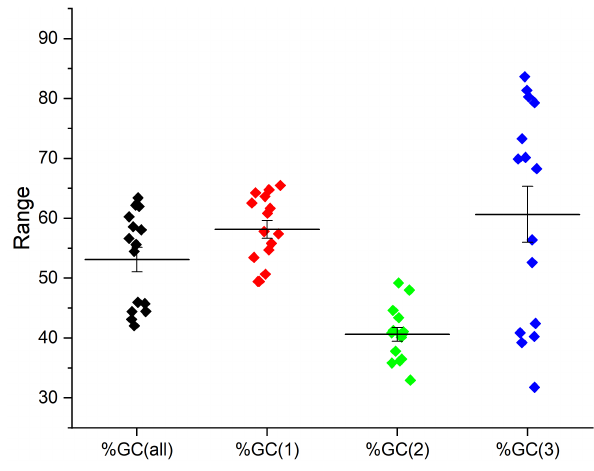
Fig. 1. The %GC compositional analysis in coding sequences. %GC(2) was minimum, while %GC(1) composition was